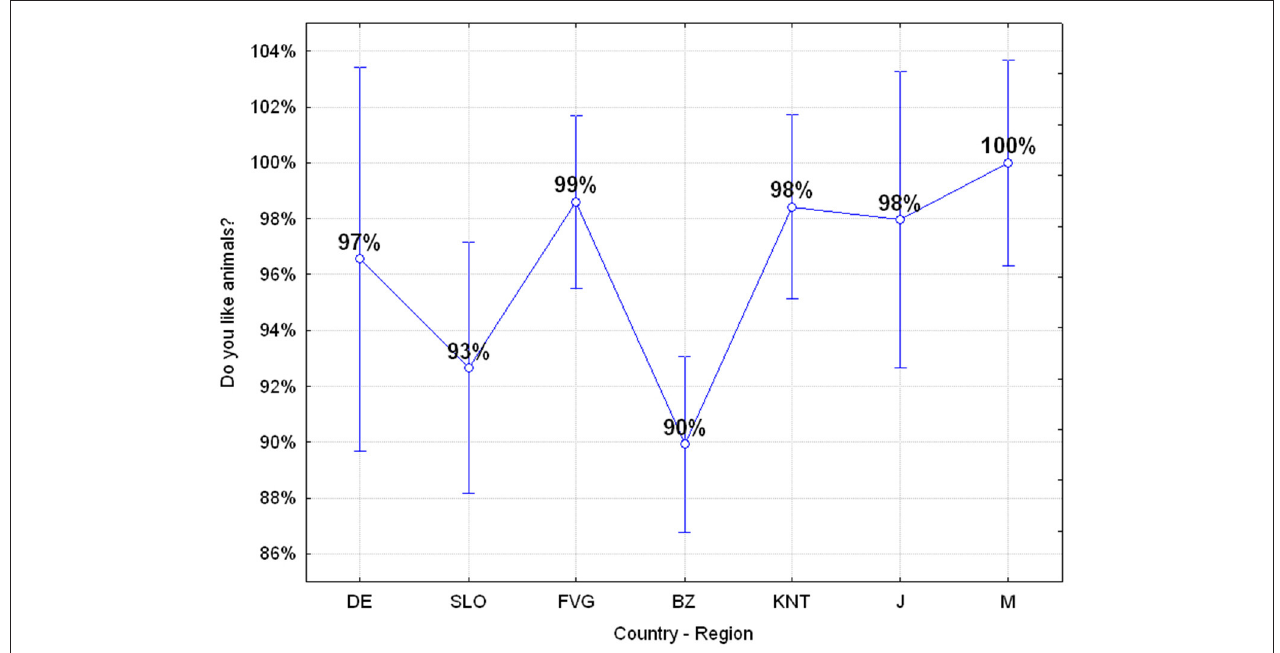
FIGURE 4 | Q1: “Do you like animals?” ANOVA F (6,649) p = 0.00023 [Axes X regions or countries, Axes Y % correct answers–DE, Germany; SLO, Slovenia; FVG, Friuli Venezia Giulia Italy; BZ, Autonomous Province of Bolzano Italy; KNT, Carinthia Austria; J, Japan; M, Mauritius–( n = 656)].